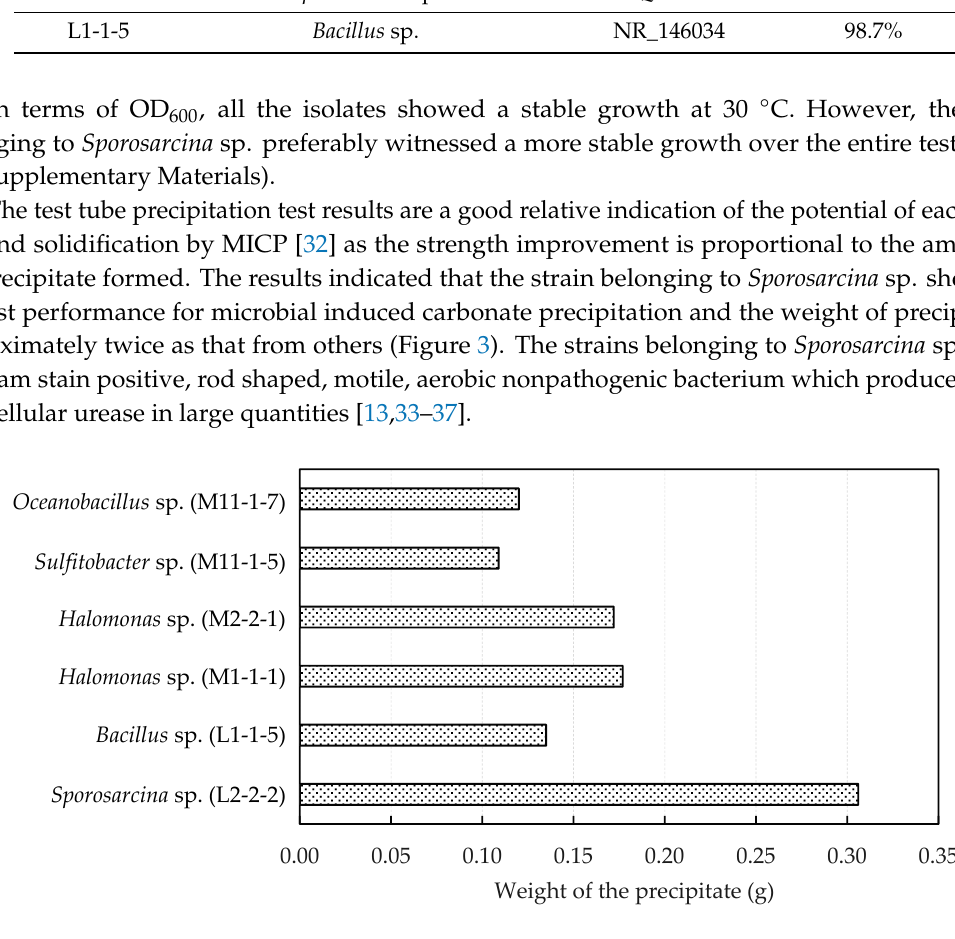
Figure 3. Microbial induced carbonate precipitation capacity of isolated strains.